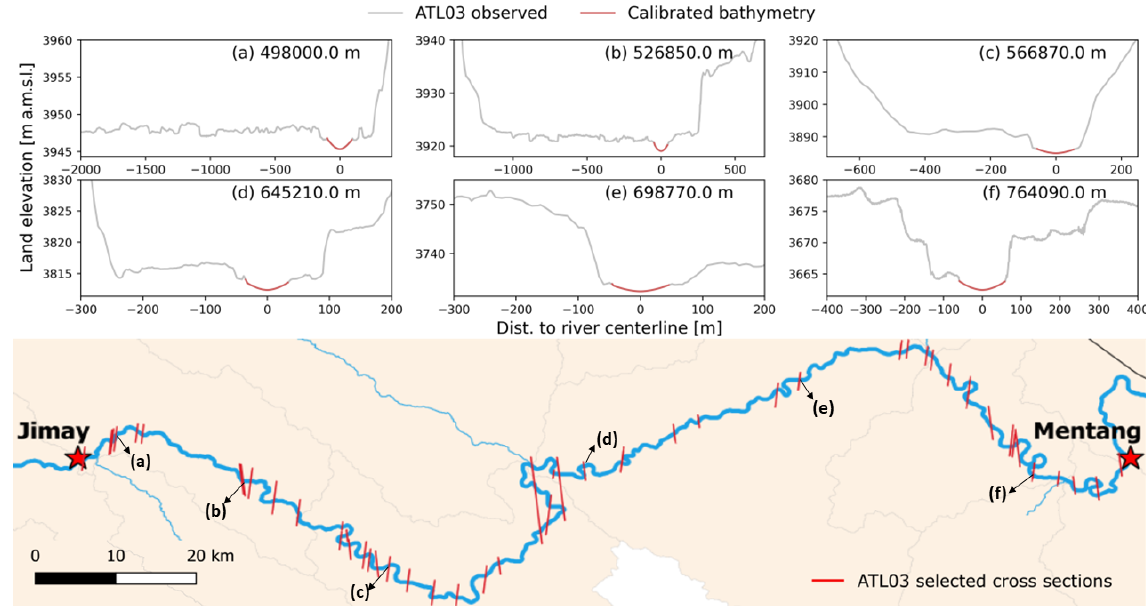
Figure 5. Panels (a–f) show examples of cross section geometry after calibration, where the majority of points correspond to ATL03 observed data. The bottom panel shows ATL03-selected cross sections for river hydraulic calibration. A total of 80 cross section were selected after the processing described in Sect. 2.1.1. The cross section shown in the top plot is located in the river.